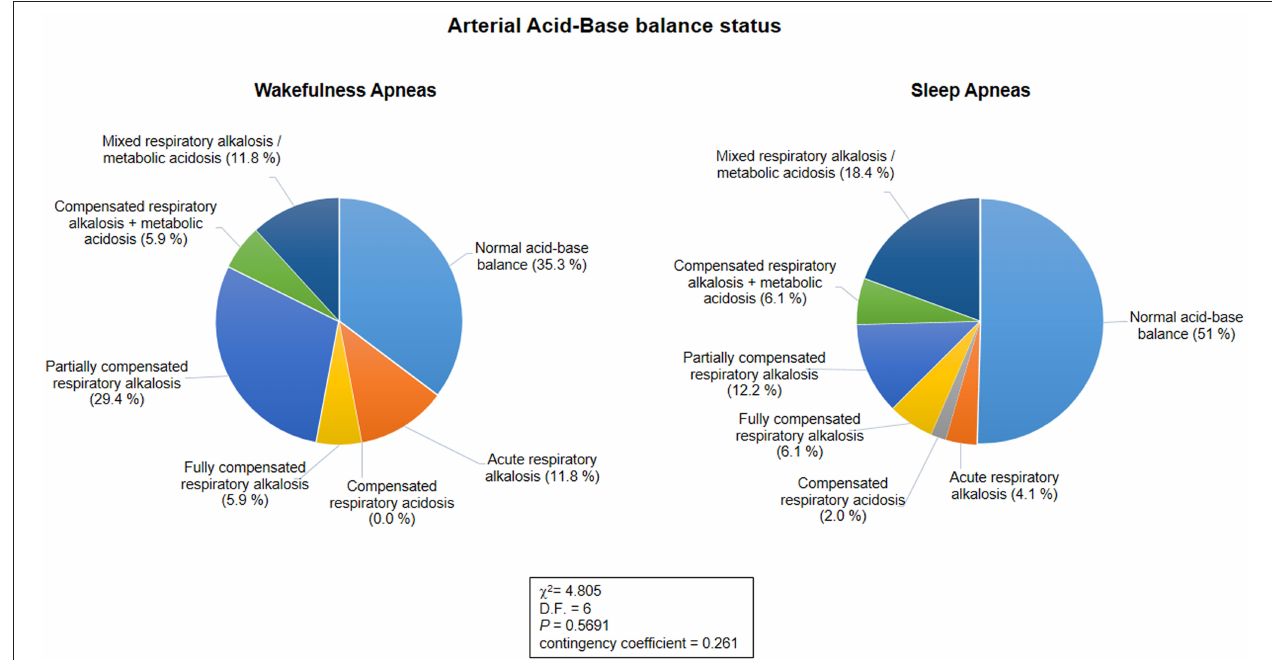
FIGURE 3 | Arterial acid-base balance status as a function of the sleep-wakefulness cycle ( n = 66). No statistical differences were observed in arterial acid-base balance patterns between the wakefulness and sleep apnea subpopulations ( p = 0.5691).